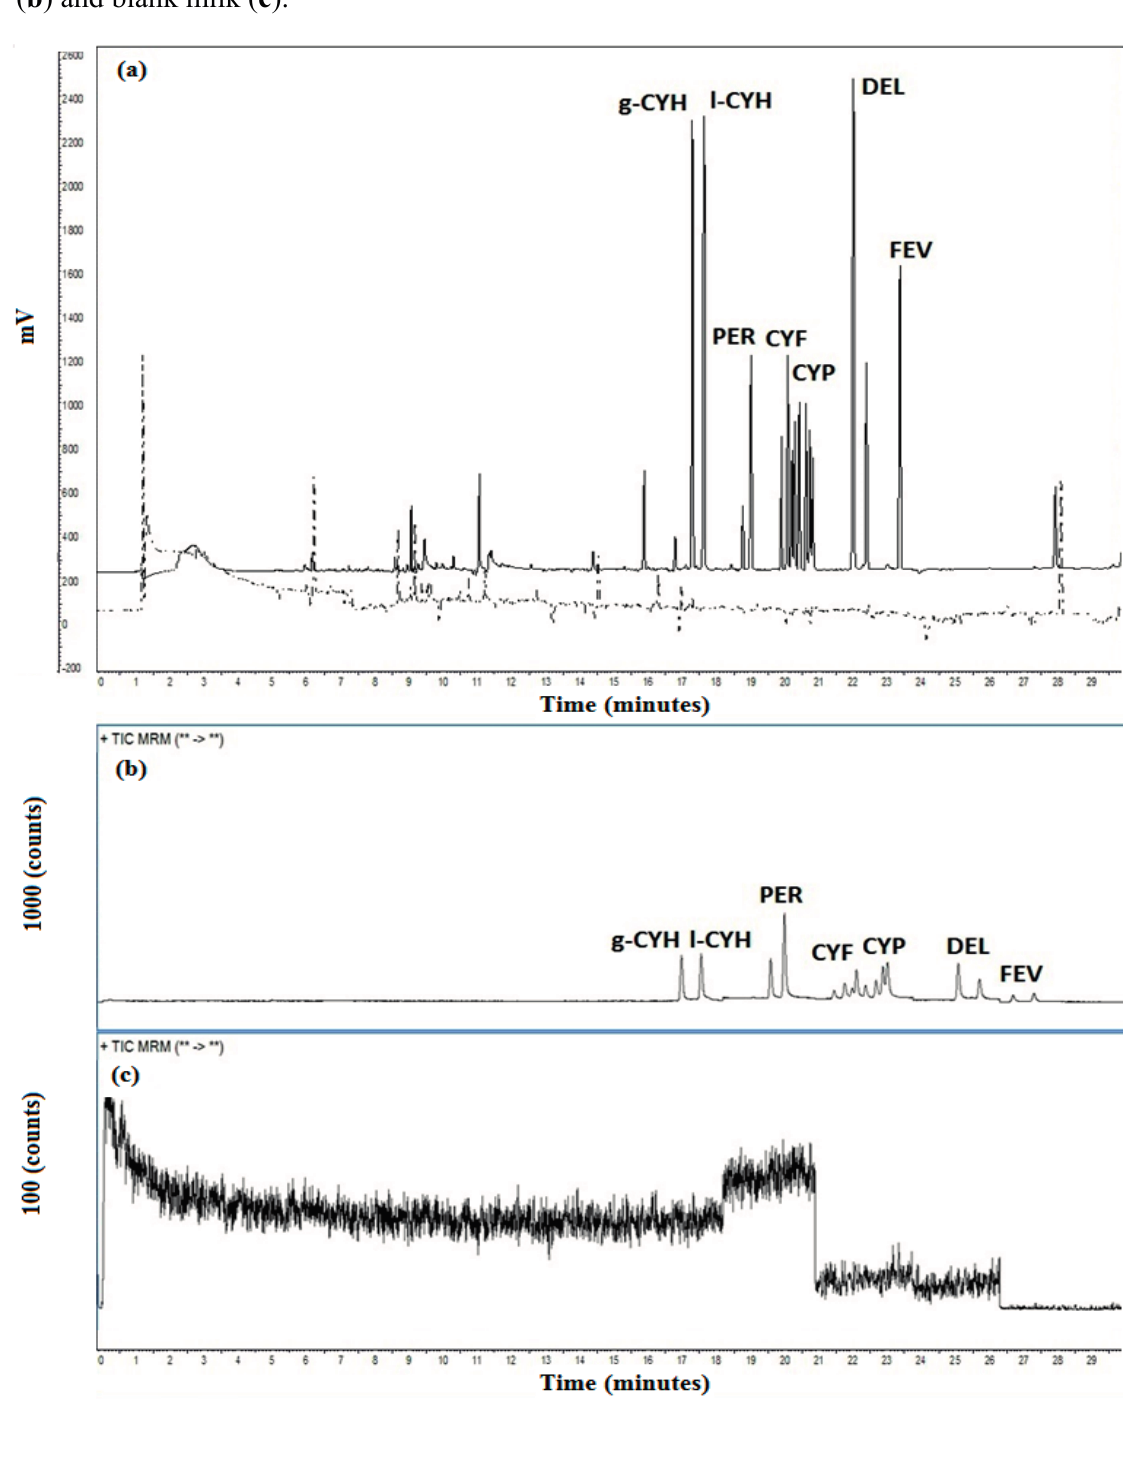
Figure 4. Comparison between chromatographic profiles for GC-ECD analyses ( a ) in spiked sample (solid line), blank milk (dotted line) and GC-MS/MS for spiked sample ( b ) and blank milk ( c